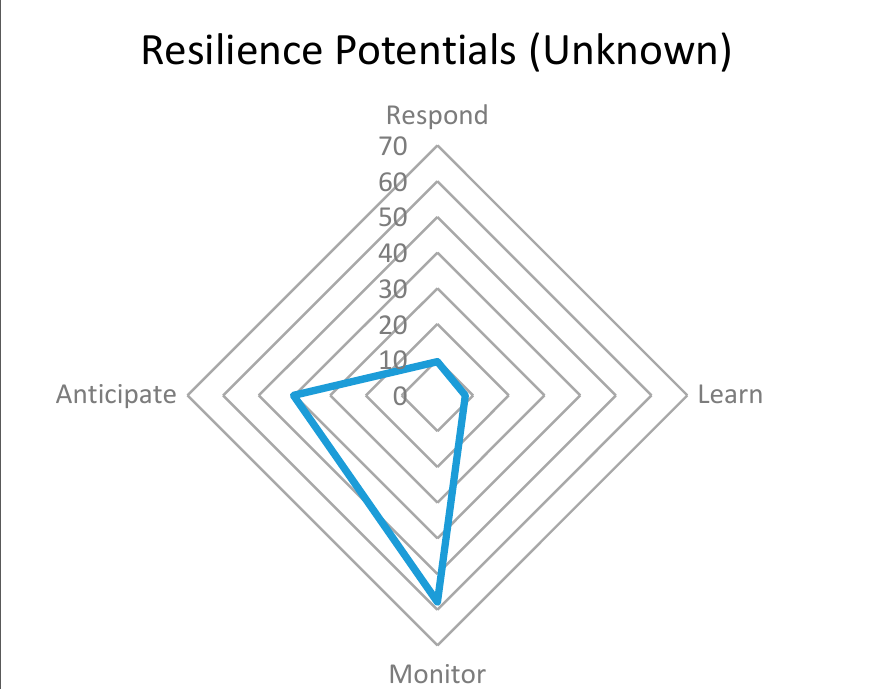
Figure 8. Four potentials percentage of Unknown responses.